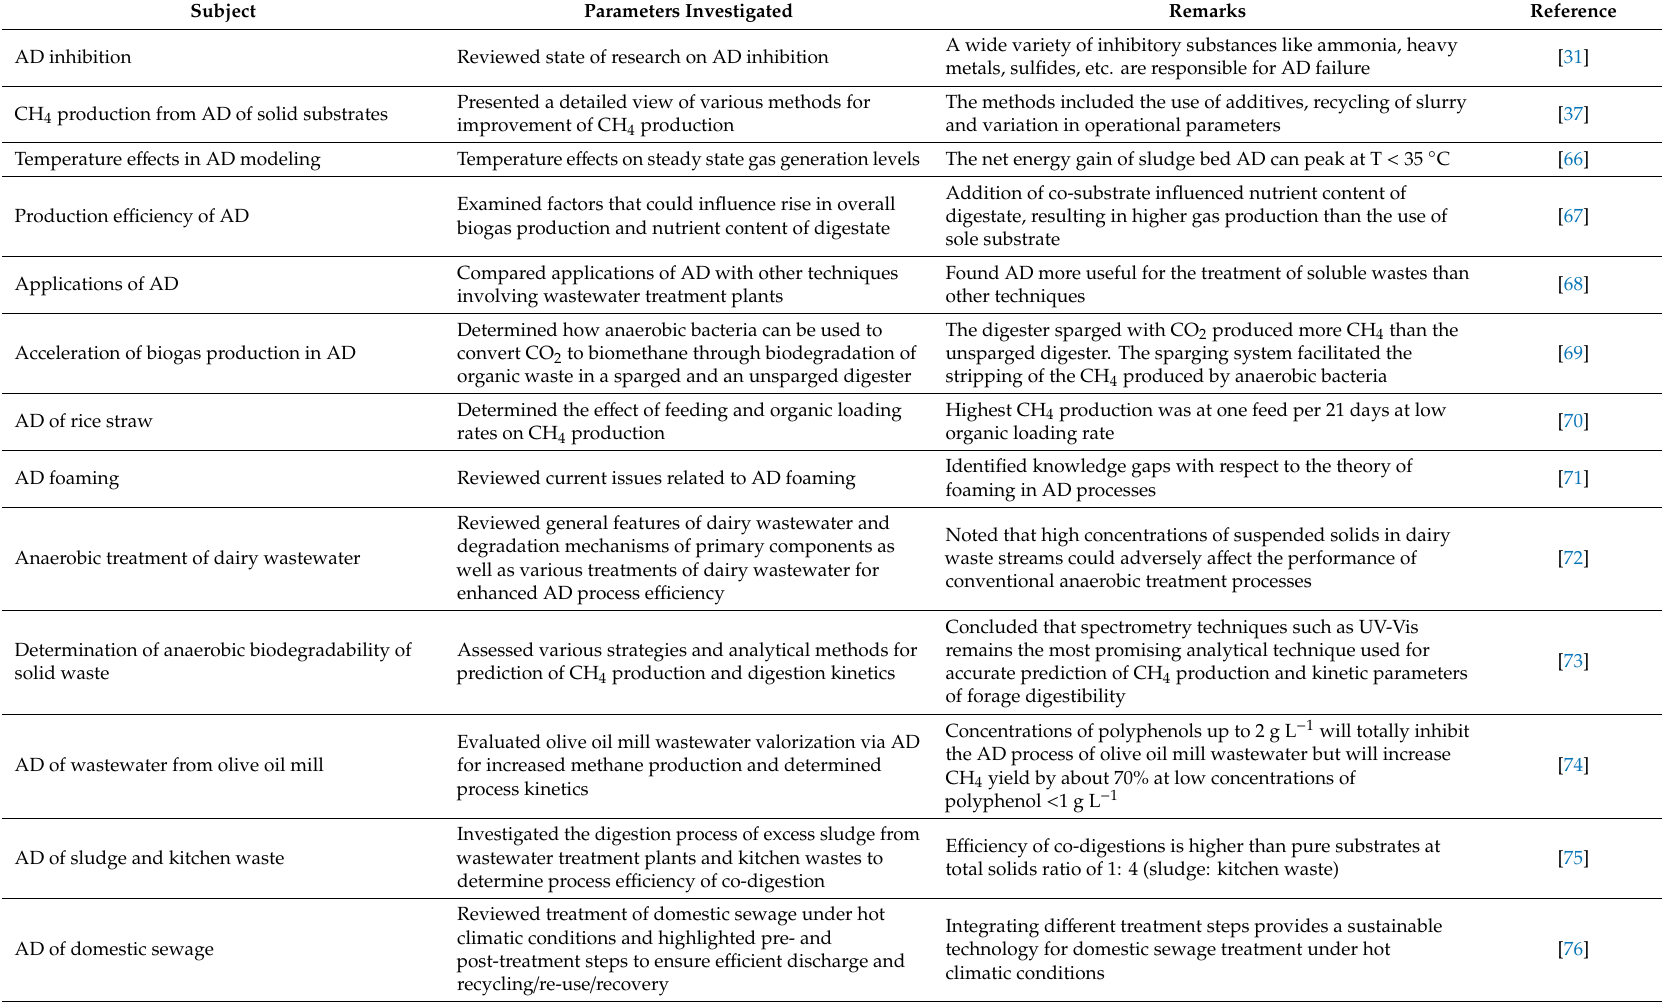
Table 4. Summarized outlines of some previous studies on anaerobic digestion undertaken by other